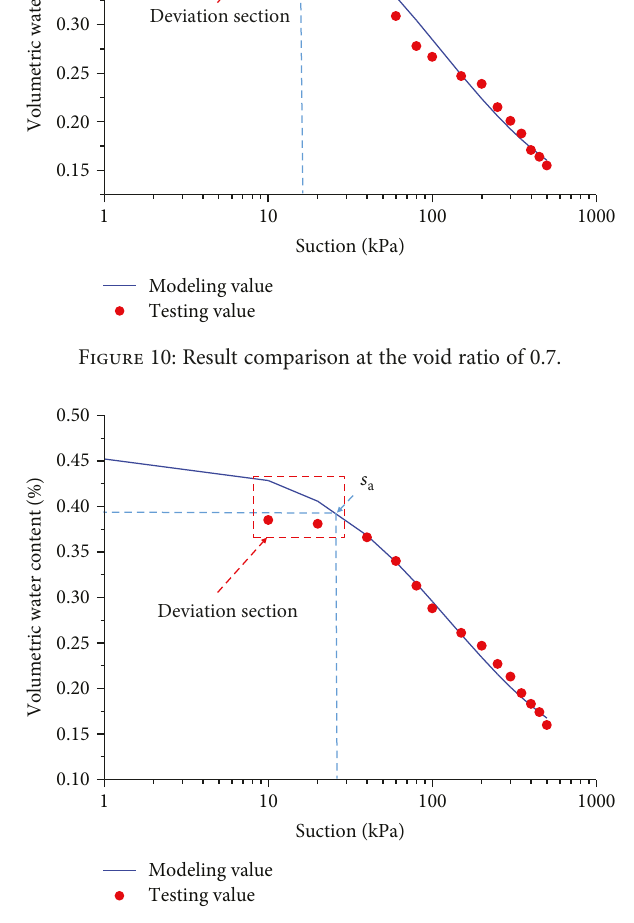
Figure 11: Result comparison at the void ratio of